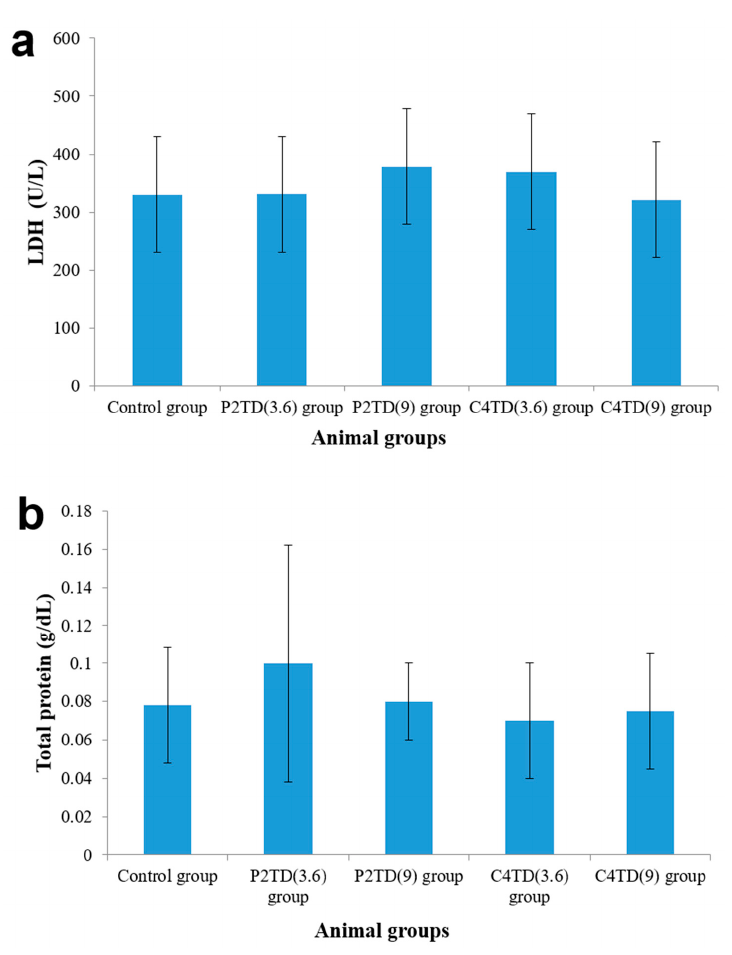
Figure 5. ( a ) LDH and ( b ) total protein content determined in BAL fluid of different rat groups ( n = 5) after oro-tracheal administration of TD-NEs. The results are presented as ±S.D. All groups were statistically compared to the control group revealing non-significant difference ( p > 0.05).